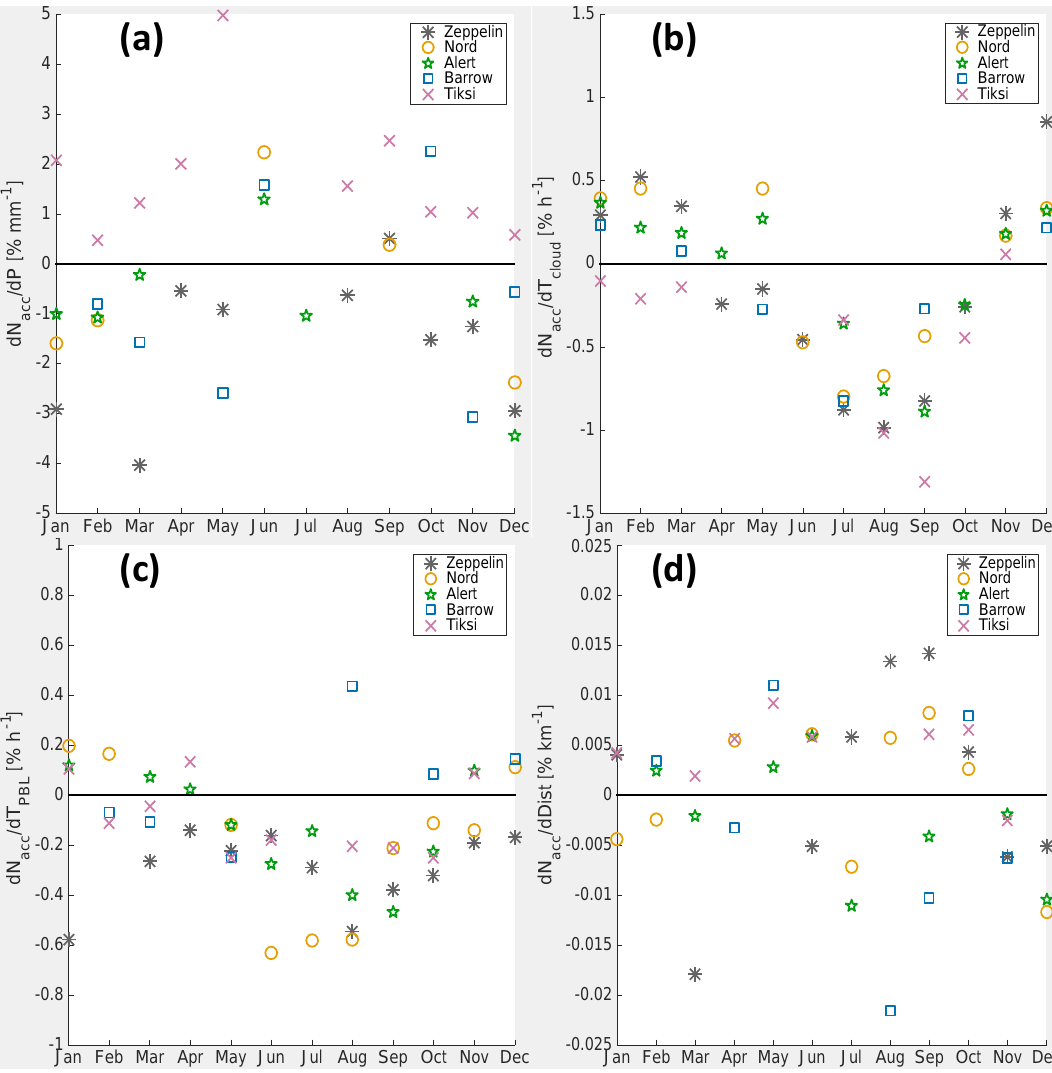
Figure 11. The derivative of aerosol accumulation-mode concentration with each of the trajectory-derived parameters shown in Fig. 10 – for each month and site. Positive values indicate the percentage increase in accumulation-mode concentration with a unit increase in the corresponding parameter, while negative values show the opposite. Only statistically significant values ( P <0.05) are